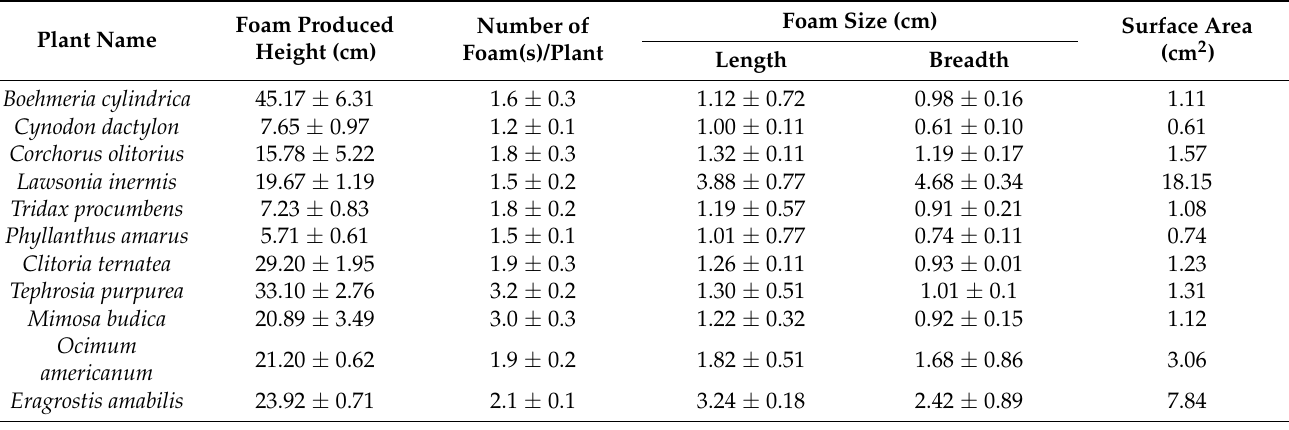
Table 2. Length and breadth (cm) of foam produced by P. costalis on various plants available on St. Xavier’s College campus. Plant